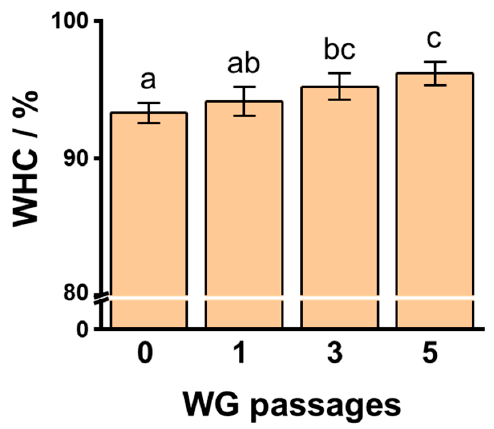
Figure 4. The water holding capacity (WHC) of 6% soybean protein isolate (SPI) gels to which 1% wet-type grinder (WG)-treated okara was added after different passages at 1.0% sodium chloride concentration. Different letters indicate significant differences ( p < 0.01).